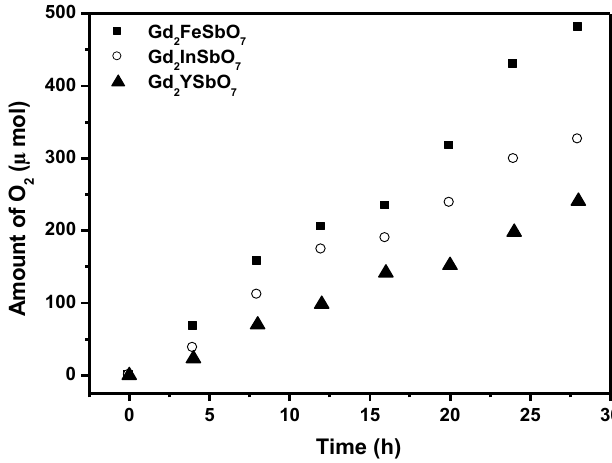
Figure 4. Photocatalytic O 2 evolution from AgNO 3 solution with Gd 2 FeSbO 7 , Gd 2 InSbO 7 or Gd 2 YSbO 7 as catalyst under visible light irradiation (λ > 420 nm, 0.5 g photocatalyst, 1 mmol AgNO 3 , 270 mL pure water). Light source: 300 W Xe